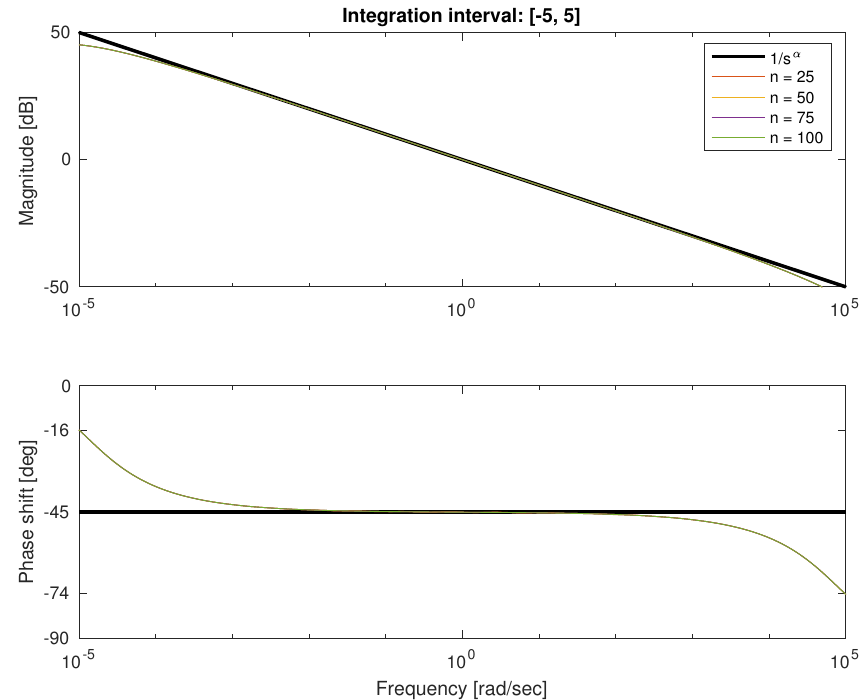
Figure 12. Analysis of frequency responses approximations with Gauss–Legendre quadrature and the integration interval of [ − 5,5 ] .